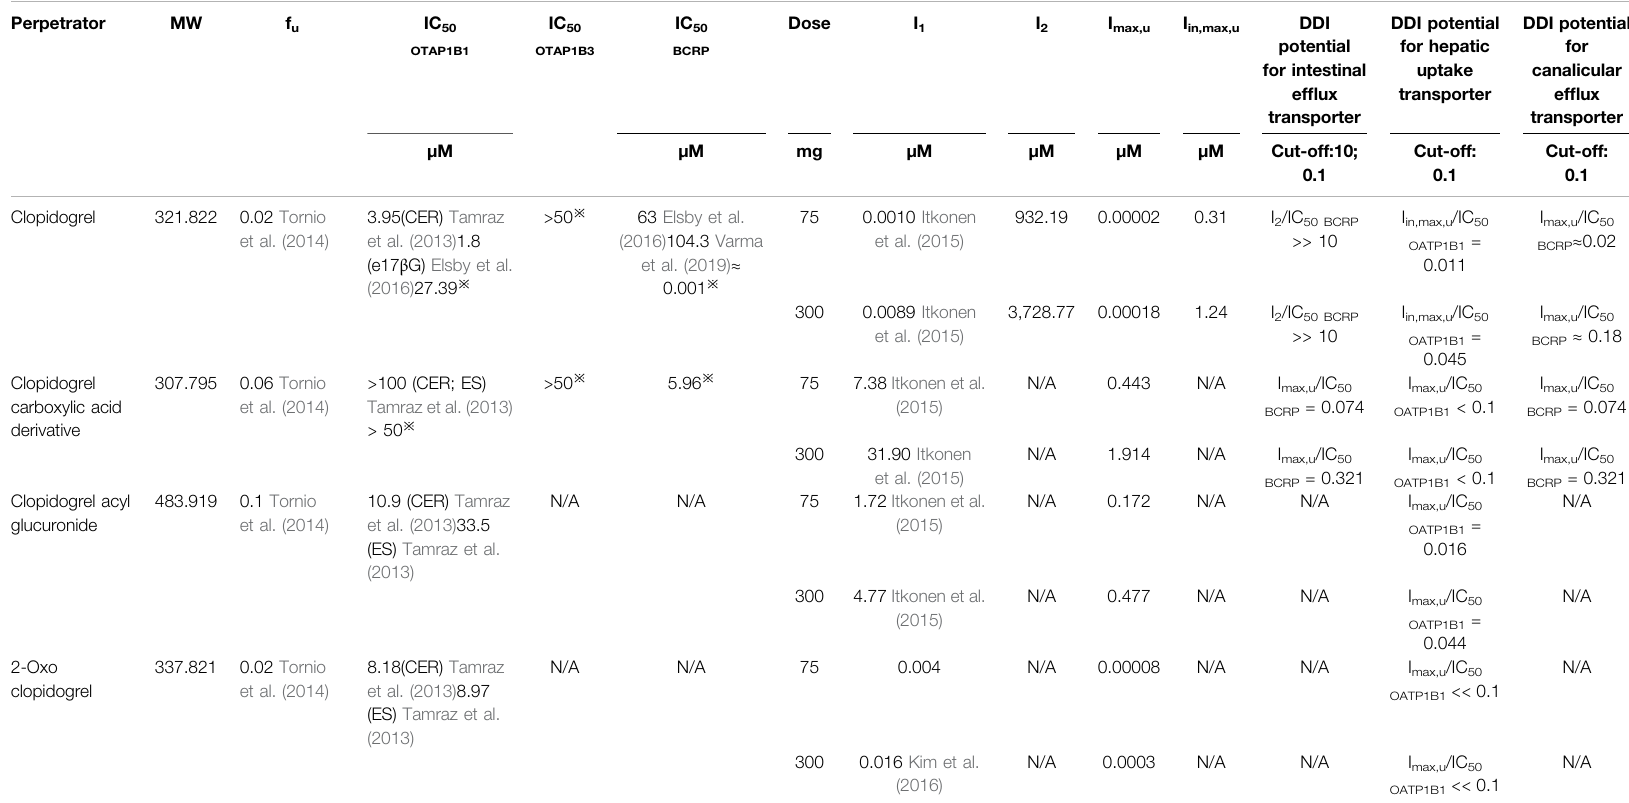
TABLE 3 | Summary of inhibitory properties and pharmacokinetic parameters of clopidogrel (CP), clopidogrel carboxylic acid (CPC), clopidogrel acyl- β -D-glucuronide, 2-oxo clopidogrel at clinically relevant doses.